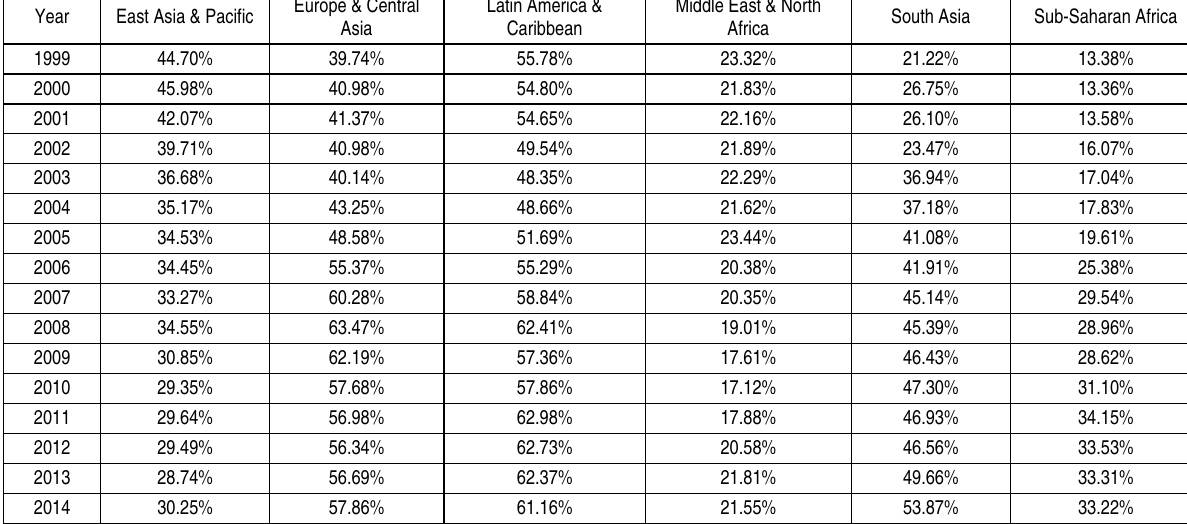
Table 4 (cont.). Trends in VR external debt as a percentage of total gross external debt region-wise